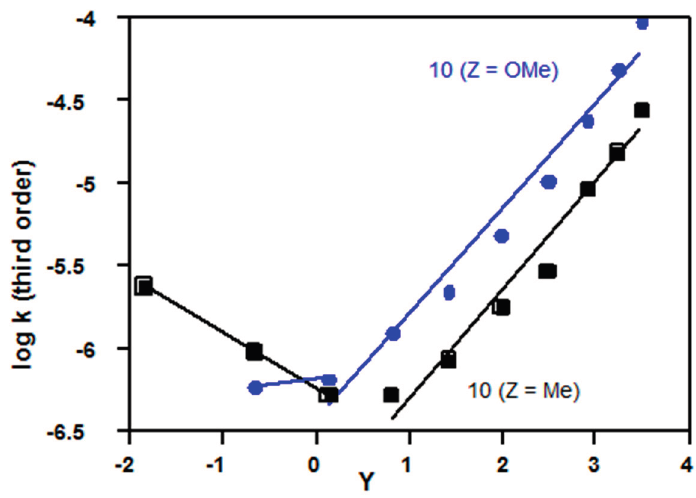
Figure 11. Plots of log k 3 vs. Y Equation (3) for solvolyses in acetone-water of 4- Z -2,6-di-methylbenzene sulfonyl chloride ( 10 , Z = Me, OMe) at 25 °C; kinetic